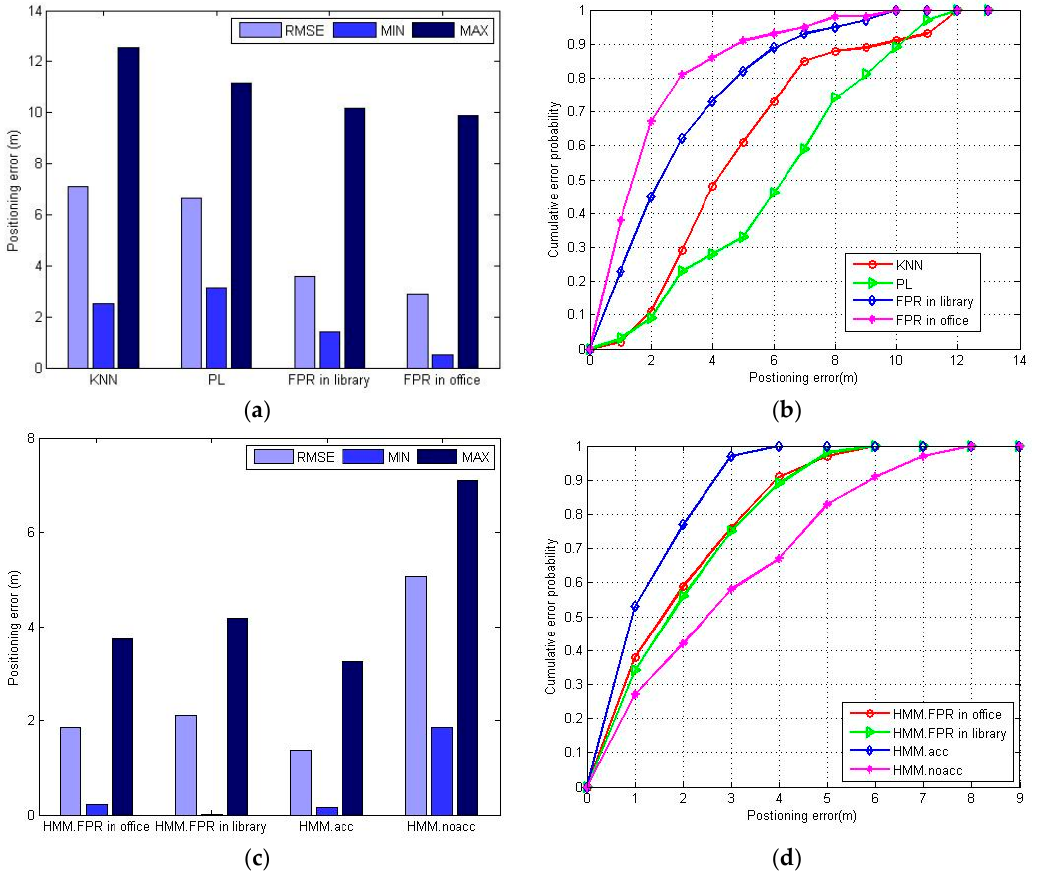
Figure 18. The positioning error of the different algorithms and methods: ( a ) maximum positioning error, minimum positioning error and RMSE of different positioning algorithms; ( b ) CDF of different positioning algorithms; ( c ) maximum positioning error, minimum positioning error and RMSE of different positioning methods; ( d ) CDF of different positioning methods.